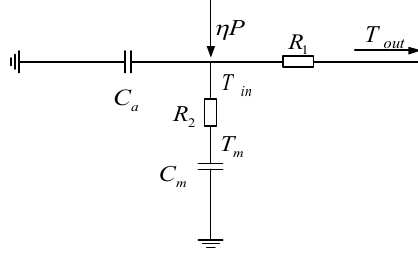
Figure 1. Air conditioning equivalent thermal parameter model.